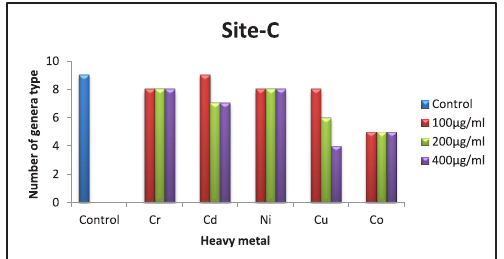
Fig. 2c. Diversity of soil fungal genera at different concentration of heavy metals from